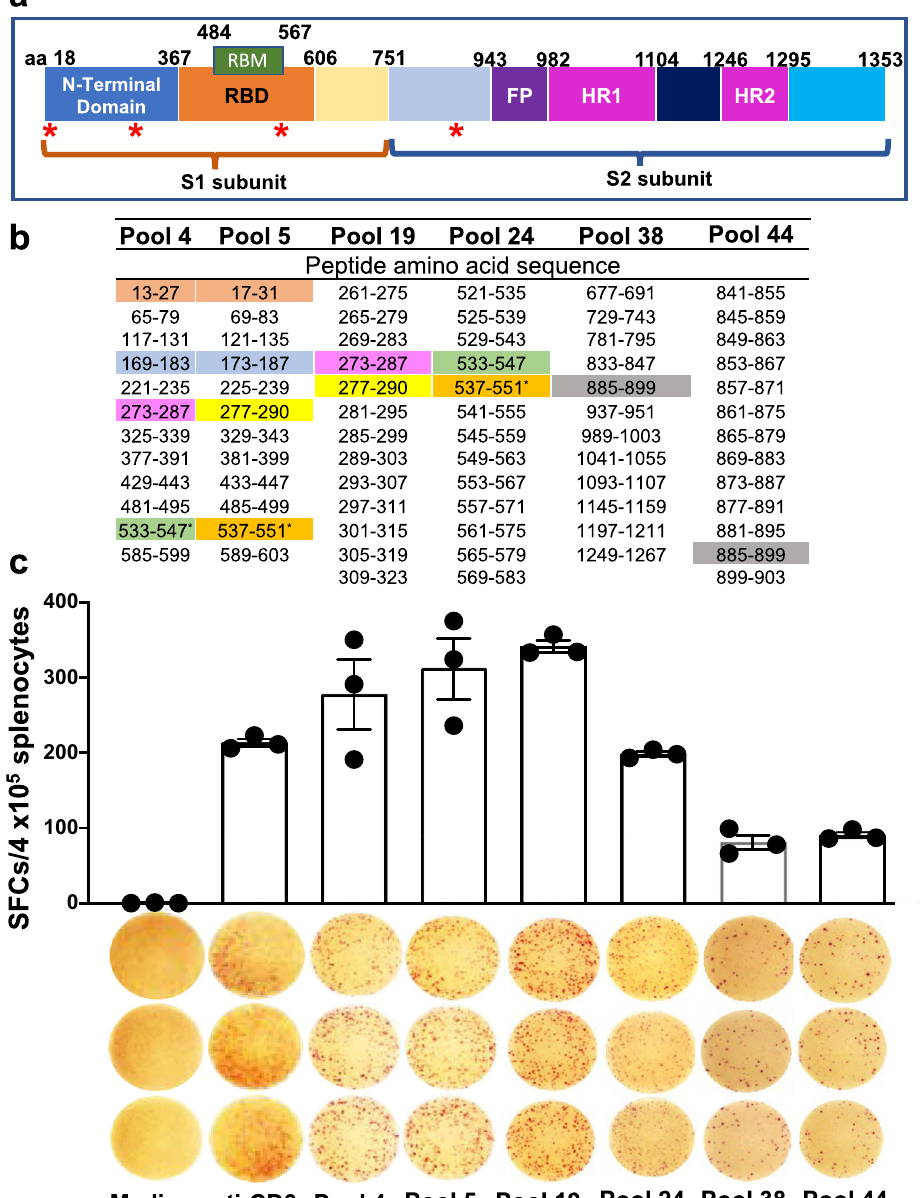
Fig. 6 Epitope mapping data in the splenocytes of SpFN vaccinated mice at week 6 following prime-boost vaccination. a Schematic representation of the SARS-CoV-2 spike protein showing the different domains with amino acid (aa) numbers. Red asterisk denotes the identi fi ed H2K b /D b -restricted epitopes. b Amino acid residues of SARS-CoV-2 glycoprotein peptide pools. Matrix pools (4, 5, and 38) and overlapping peptide pools of 15-mer peptides overlapping by 11 aa (19, 24, and 48) containing 315 peptides across the entire glycoprotein were tested in the ELISpot assay. Reactivity to speci fi c matching sequences in pools are highlighted with different matching colors and represent the predicted epitopes for H2K b /D b (iedb.org) or predicted epitopes without ELISpot responses (blue highlight; hypothetical epitope). Amino acid sequences 13 – 27 (pool 4) and 17 – 31 (pool 5) have been highlighted in color to indicate con fi rmed epitopes based on ELISpot reactivity to peptide pool 14. c Number of spike-speci fi c IFN- γ spot forming units stimulated with 52 peptide pools from the Epitope Mapping Peptide Set of the spike protein is presented as scatter plots (mean ± s.d./4 × 10 5 splenocytes). ELISpot images of triplicate wells and the stimulants are shown on the X-axis. T cell responses were considered positive when mean spot count exceeded the mean ± 3 s.d. of the negative control wells. Splenocytes were stimulated in vitro with media (negative control), anti-CD3 (positive control), or SARS-CoV-2 spike peptide pools 4, 5, 19, 24, 38, and